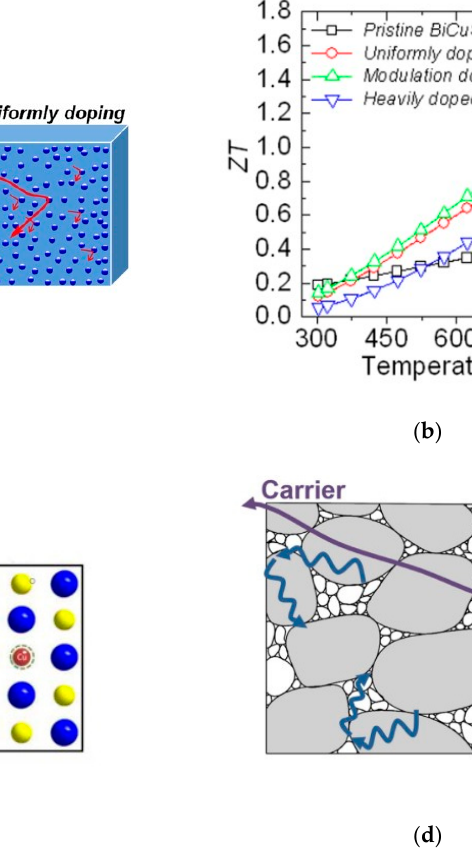
Figure 4. ( a ) Schematic representations of pristine BiCuSeO, modulation-doped sample, and heavily doped sample. Reprinted with permission from [81]. ( b ) ZT as a function of temperature for the pristine, modulation-doped, uniformly doped, and heavily doped BiCuSeO. Reprinted with permission from [81]. ( c ) An illustration of intrinsic Pb vacancies filled by Cu atoms to improve μ. Reprinted with permission from [79]. ( d ) Schematic representations of carrier and phonon-transport paths in the composite material with nanoscale and microscale grains. Reprinted with permission from [77].